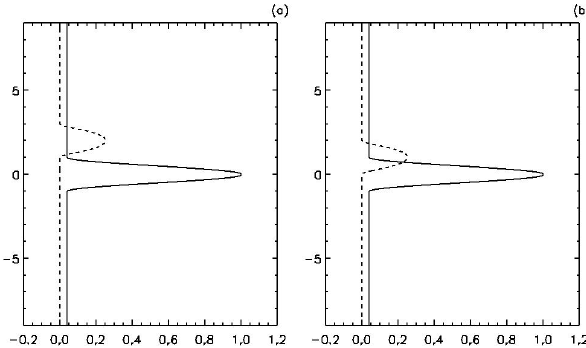
Fig. 14. Dual ducting structures utilized in Sect. 3.3. Solid lines depict the stability profile while the dashed lines in each case indi- cate the velocity ducting structure. (a) Velocity duct displacement is equal to the width of the duct. (b) Velocity duct displacement is equal to the half width of the